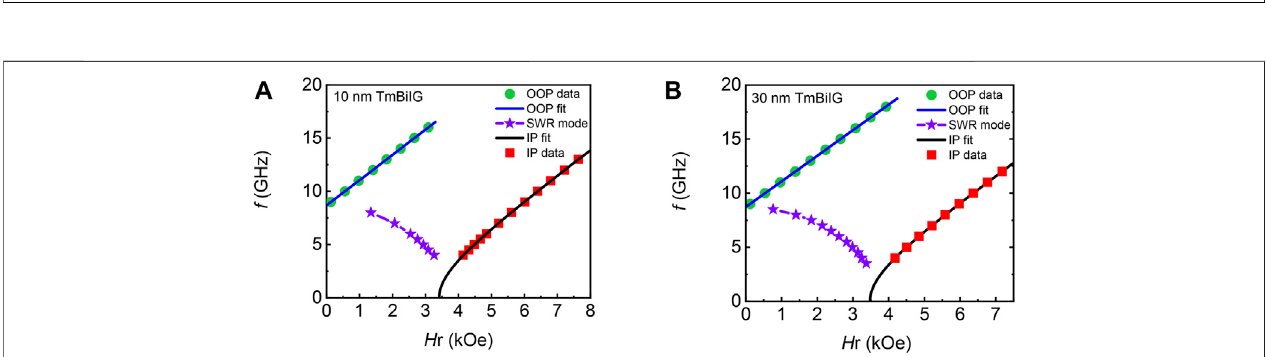
FIGURE5| FMR measurementofthe TmBiIG fi lm.In-planeferromagnetic resonancespectraof (A) 10-and (B) 30-nm-thicksamples.Out-of-plane ferromagnetic resonance spectra of (C) 10 nm thickness in 9 – 16 GHz (1 GHz interval) and (D) 30 nm thickness in 9 – 18 GHz (1 GHz interval).